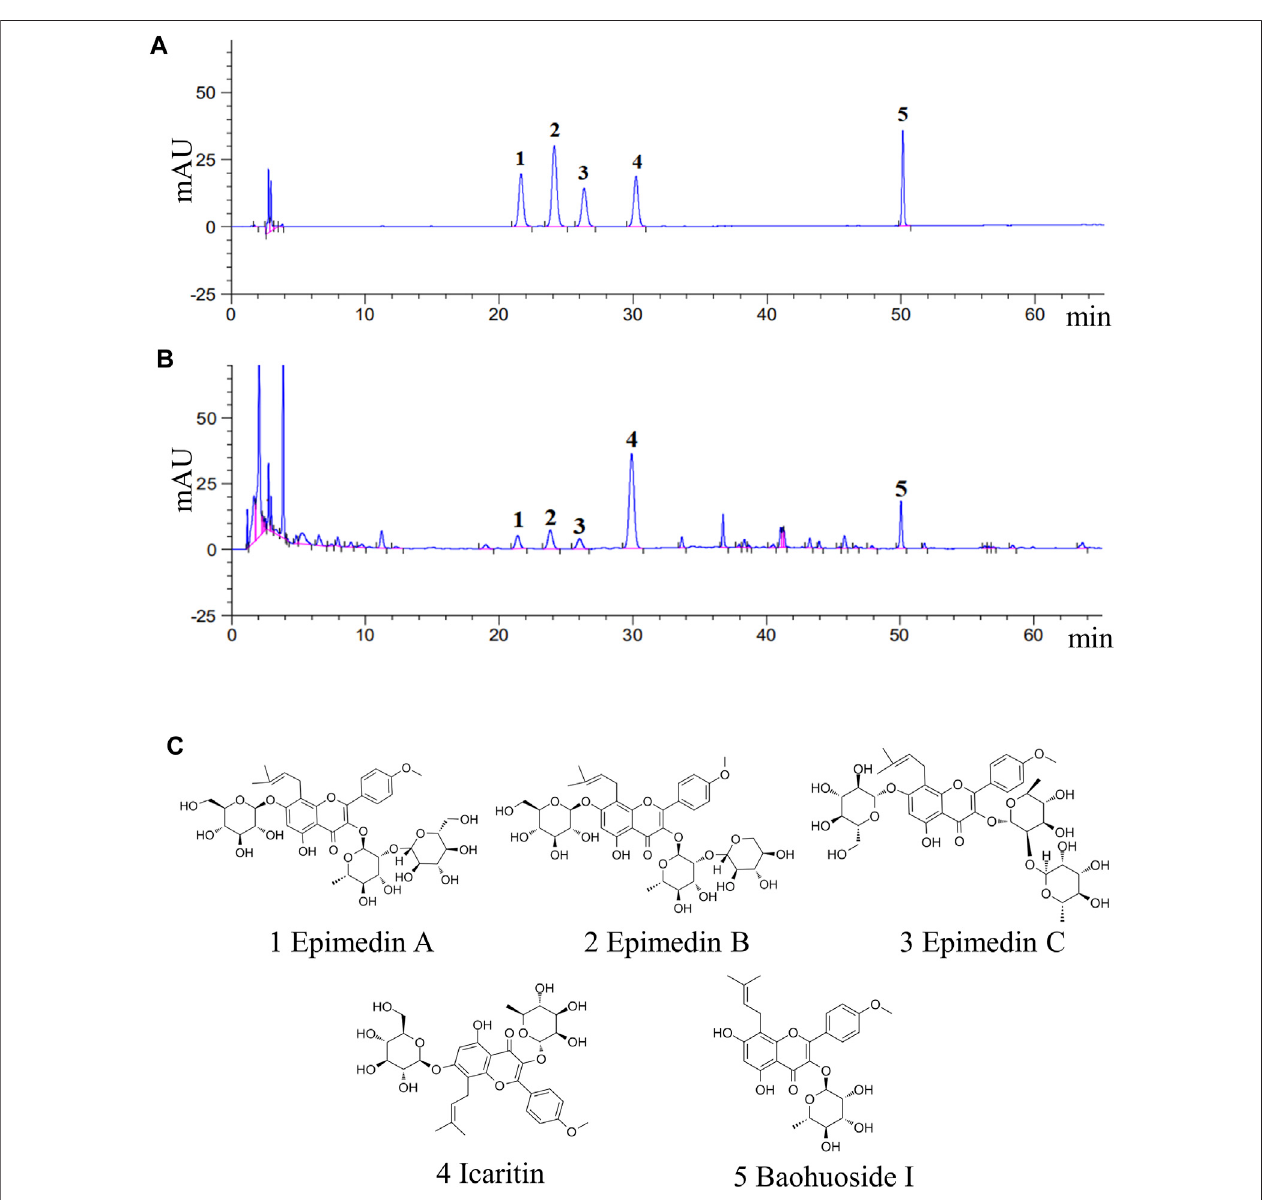
FIGURE1| The fi vemaincompoundsinEEEwerequanti fi edbyHPLCanalysis. (A,B) HPLCanalysischromatogramsofthe5maincomponentsandEEEsamples. 1, epimedin A (C 40 H 52 O 19 ); 2, epimedin B(C 38 H 48 O 19 ); 3, epimedin C(C 39 H 50 O 19 ); 4, icaritin (C 21 H 20 O 6 ); 5, baohuoside I(C 27 H 30 O 10 ). (C) Molecular structures of the 5 main components in